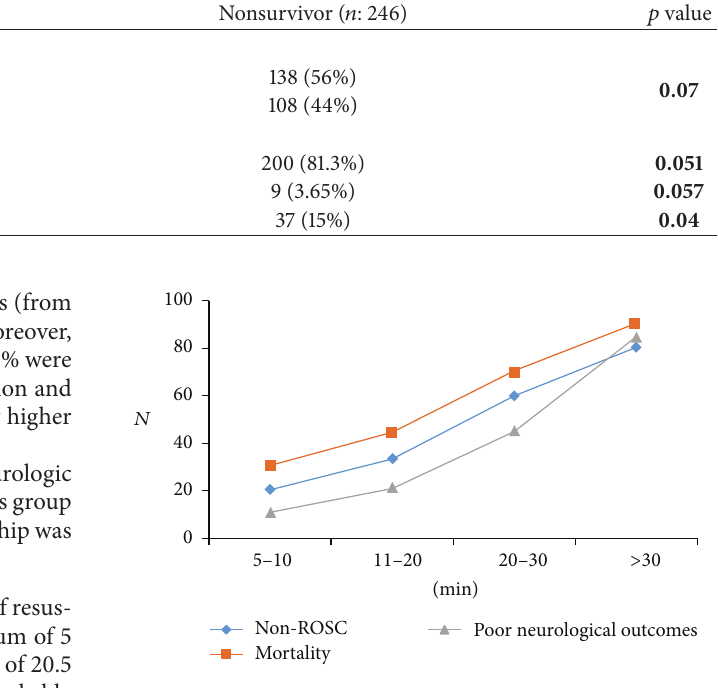
Figure 1: Duration of